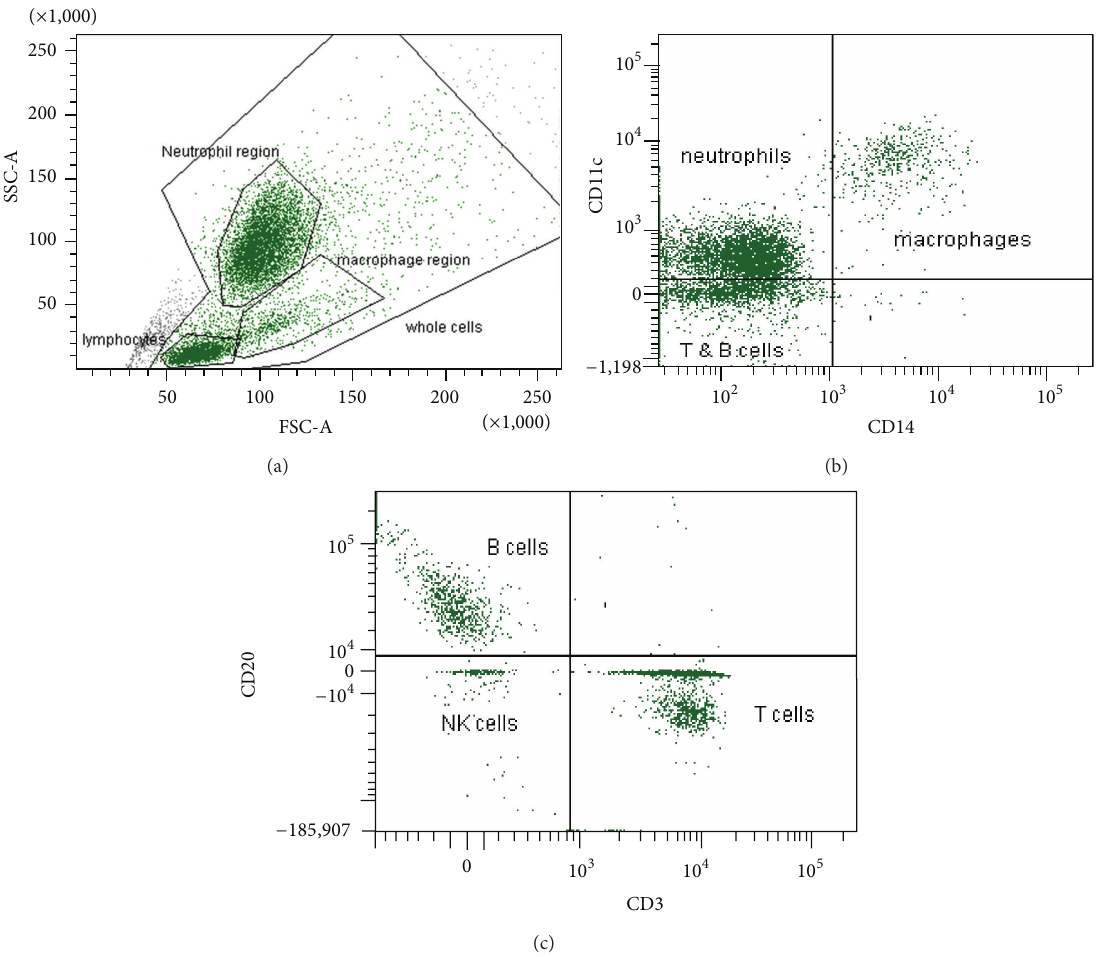
Figure 1: Flow cytometry plots. (a) Typical scatter profile from na¨ıve marmoset blood showing the difference in size (FSC) and granularity (SSC)ofthebasiccelltypes.(b)ExpressionofCD11candCD14onmonocytes/macrophagesandneutrophilsand(c)CD20andCD3expression on